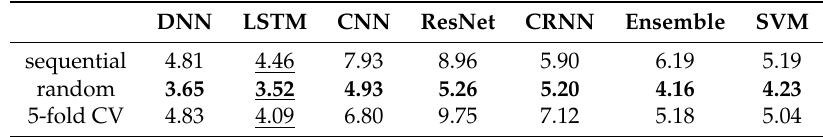
Table 9. Effect of data split methods on regression (MAPE, %). The sequence size m = 20. The log values of the major features and the first value-based normalization were